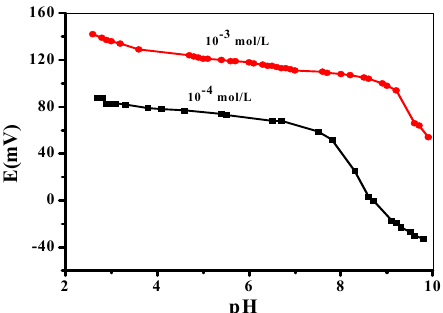
Figure 6. E ff ect of pH on the potentiometric response of the applied Figure 6. Effect of pH on the potentiometric response of the applied sensor. Table 2. The selectivity coefficients ( log log 𝐾 (cid:2890)(cid:2896)(cid:2906),(cid:2894)(cid:2900)(cid:2925)(cid:2930) ) of the proposed sensor with and without MWCNT.